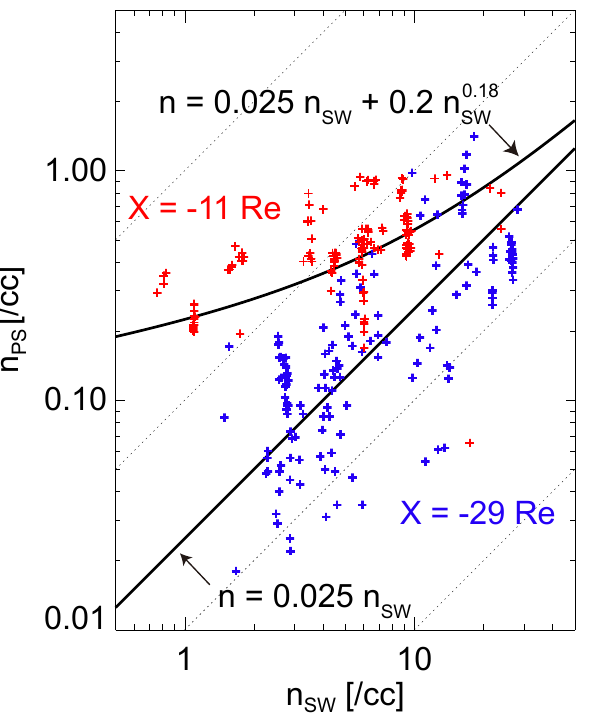
Fig. 11. Plasma sheet number density versus solar wind number density at the midnight meridian for different values of X . Red crosses indicate data point for X = − 11 R E and blue crosses for X = − 29 R E . Line indicates the purely solar wind origin case and curve means mixture of solar wind origin and ionospheric origin